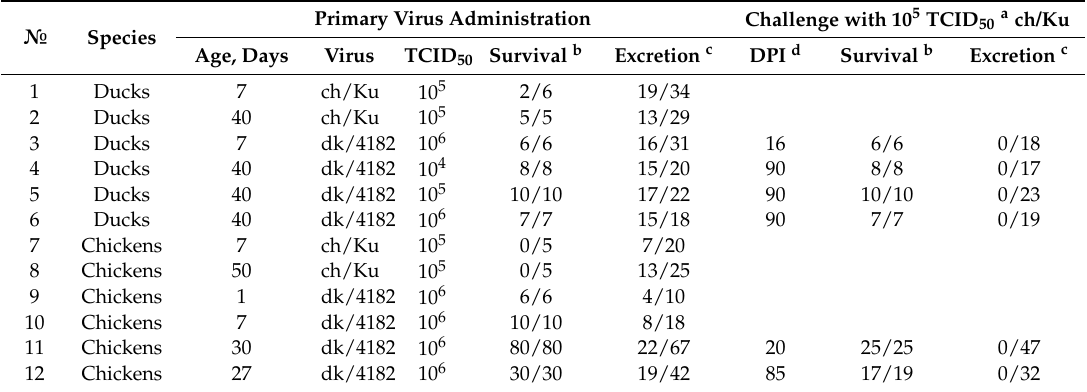
Table 1. Survival rates and fecal excretion of viruses ch/Ku and dk/4182 following primary administration to ducks and chickens via drinking water and after aerosol challenge with ch/Ku. Primary Virus Administration Challenge with 10 5 TCID 50 a ch/Ku Species